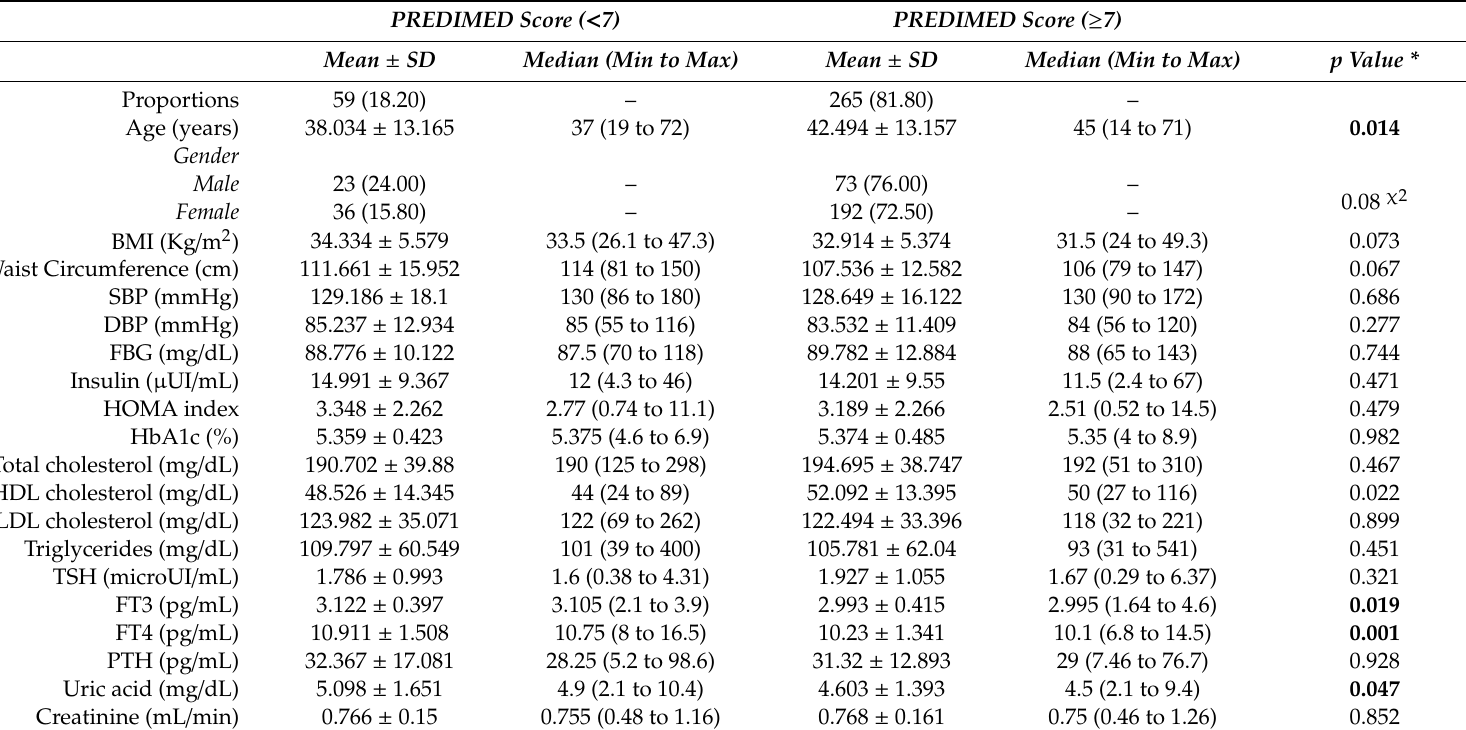
Table 1. Description of the whole sample divided by adherence to Mediterranean diet (Med-Diet) ( N =